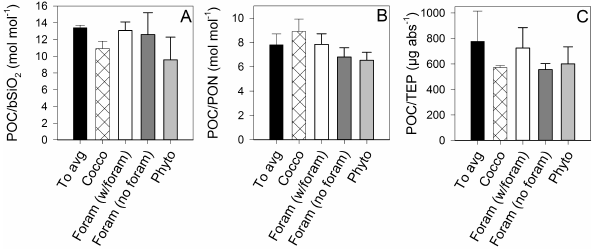
Fig. 6. The ratios of (A) POC to bSiO 2 , (B) POC to PON, and (C) POC to TEP in suspension at T 0 (the value reported represents an average of the T 0 samples for all three treatments) and in the aggre- gates at the end of the